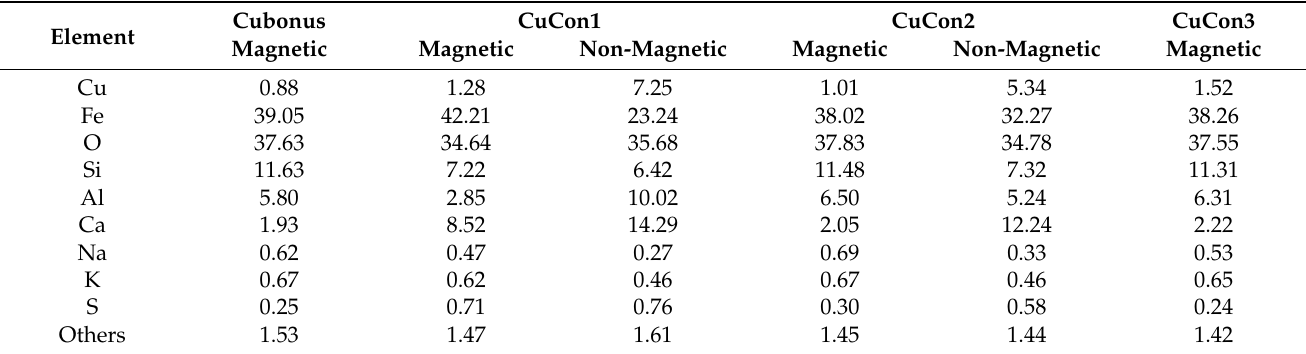
Table 5. X-ray fluorescence results.